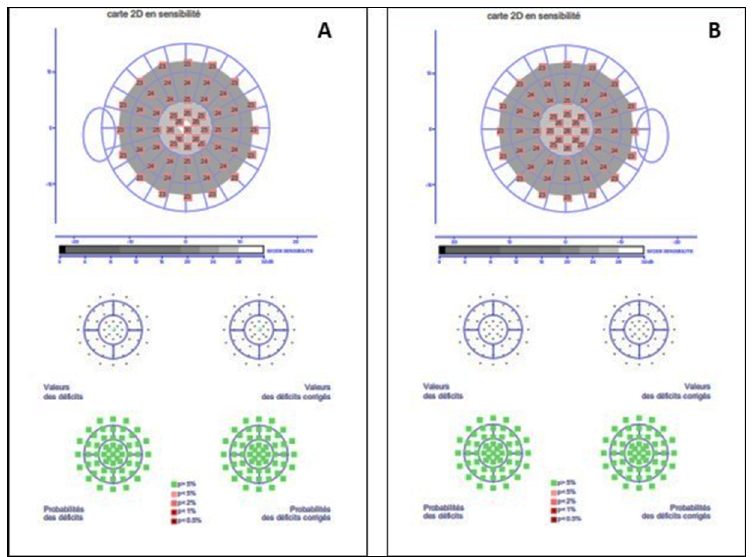
Figure 3. Static visual field test within the 12 central degree FAST 12 perimetry Metrovision visual field test showed no central field defects in either eye ( A : left eye; B : right eye).